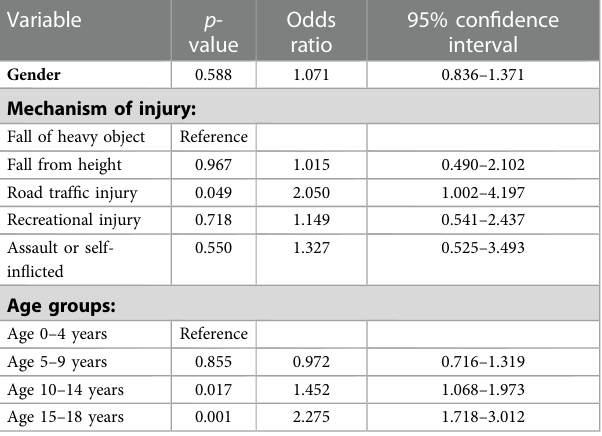
TABLE 6 Multivariable analysis to predict severe injury (ISS>15) in pediatric population.